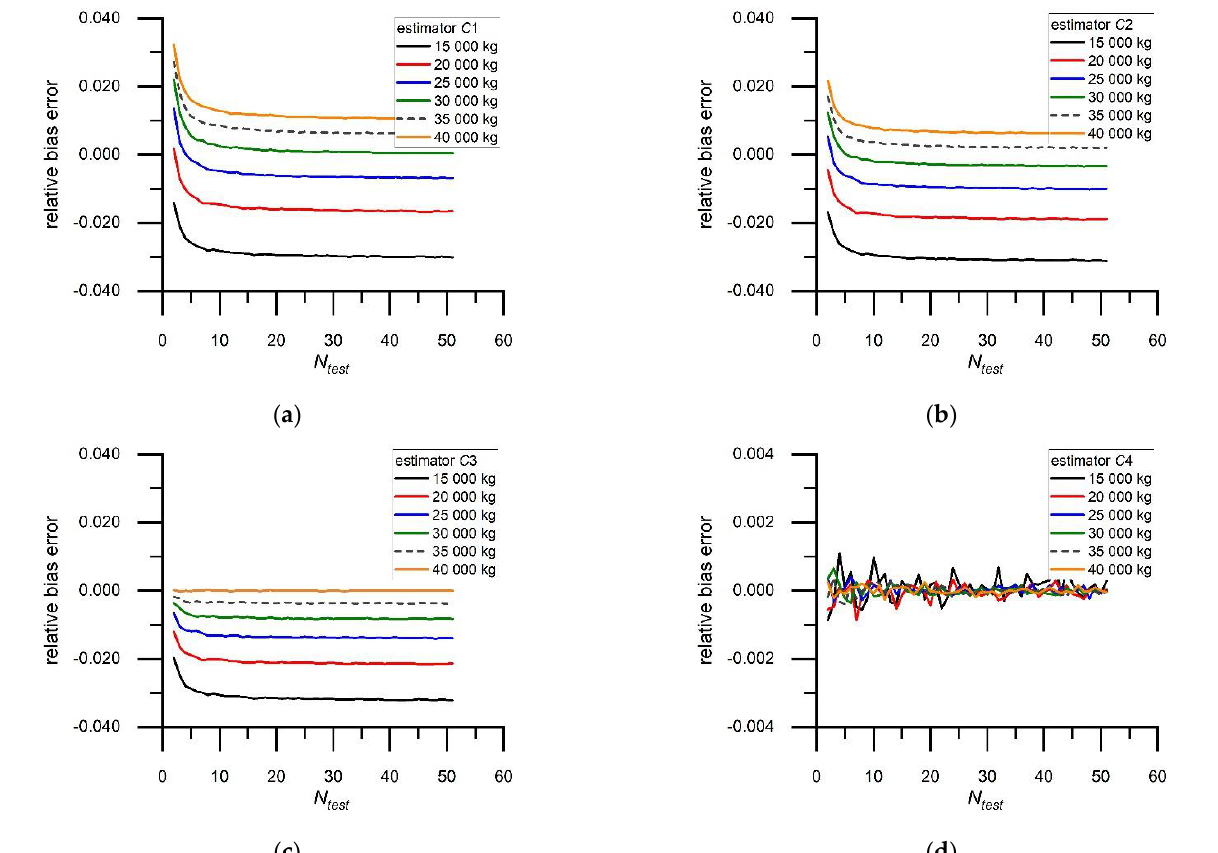
Figure 5. Influence of the weight distribution of test vehicles in the measurement range of the WIM system on the bias error of vehicle weighing results for various algorithms for estimating calibration coefficients ( 𝐶 𝑟𝑒𝑓 = 1 , 𝑏 𝑟𝑒𝑓 = 0.1𝑍 𝑚𝑖𝑛 ),